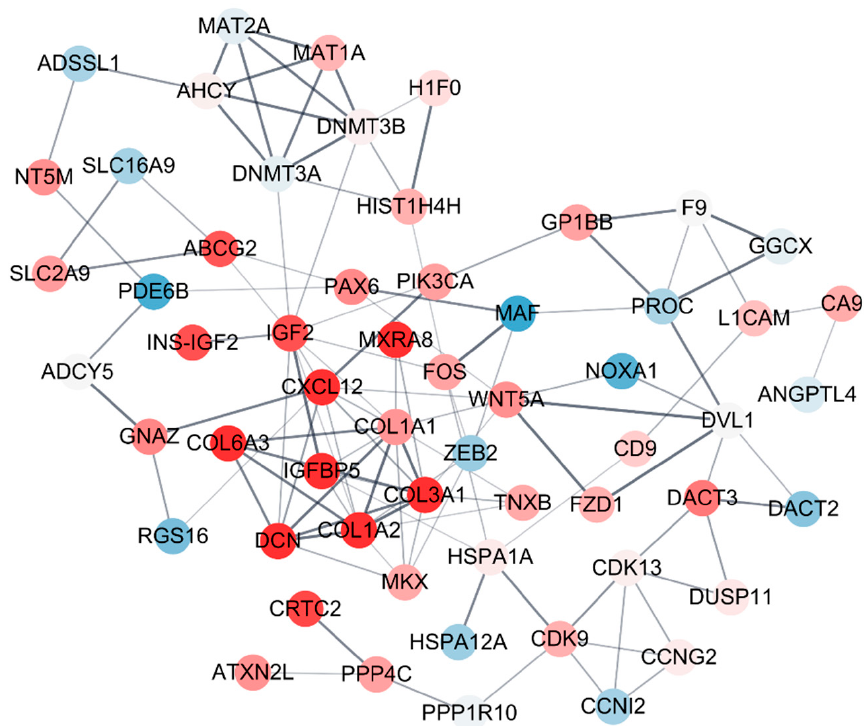
Figure 5. The protein–protein interaction (PPI) network of the biomarkers of sodium cyanide exposure. The differentially expressed genes (DEGs, ≥ 2 folds) were sorted and used for PPI analysis based on STRING DB. The module enrichment was based on the PPI network with a cutoff criterion of MCODE score >4. Each node and corner represent a gene and co-expression relationship, respectively. The pink and blue nodes indicate the upregulated and downregulated DEGs, respectively. The bold lines indicate that the connected nodes have a strong co-expression relationship.